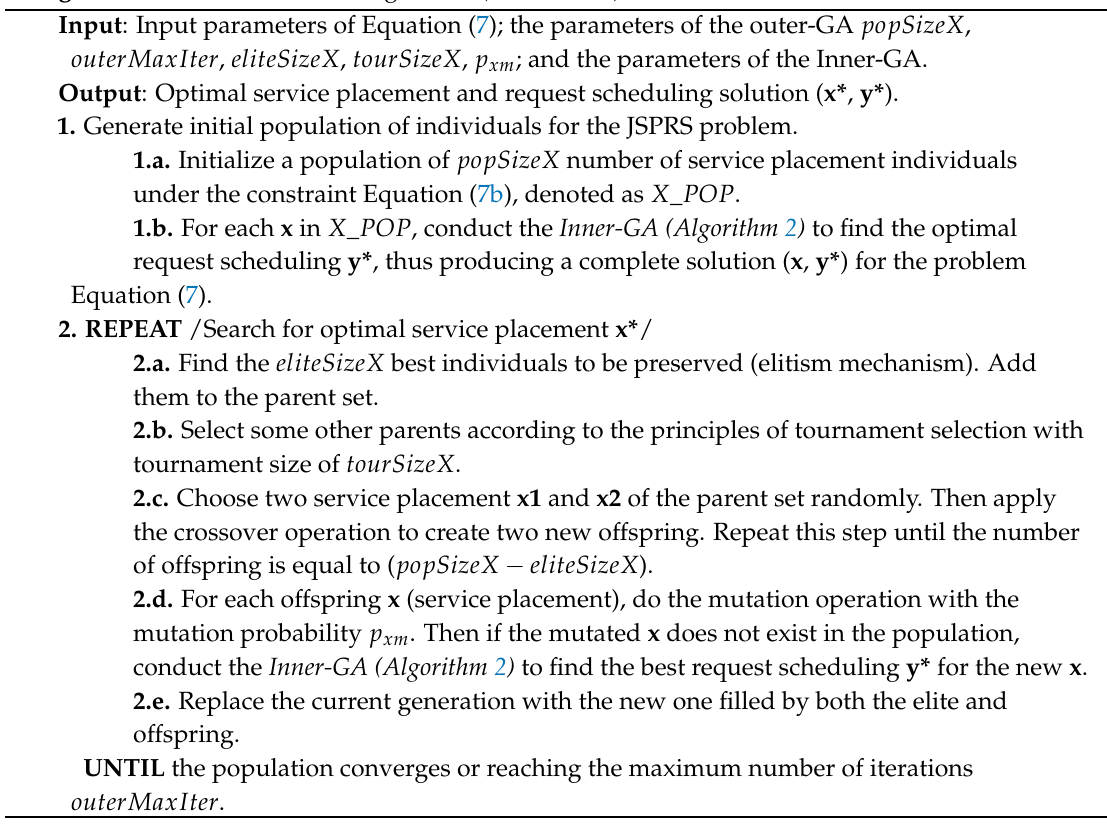
Algorithm 1: Nested-Genetic Algorithm